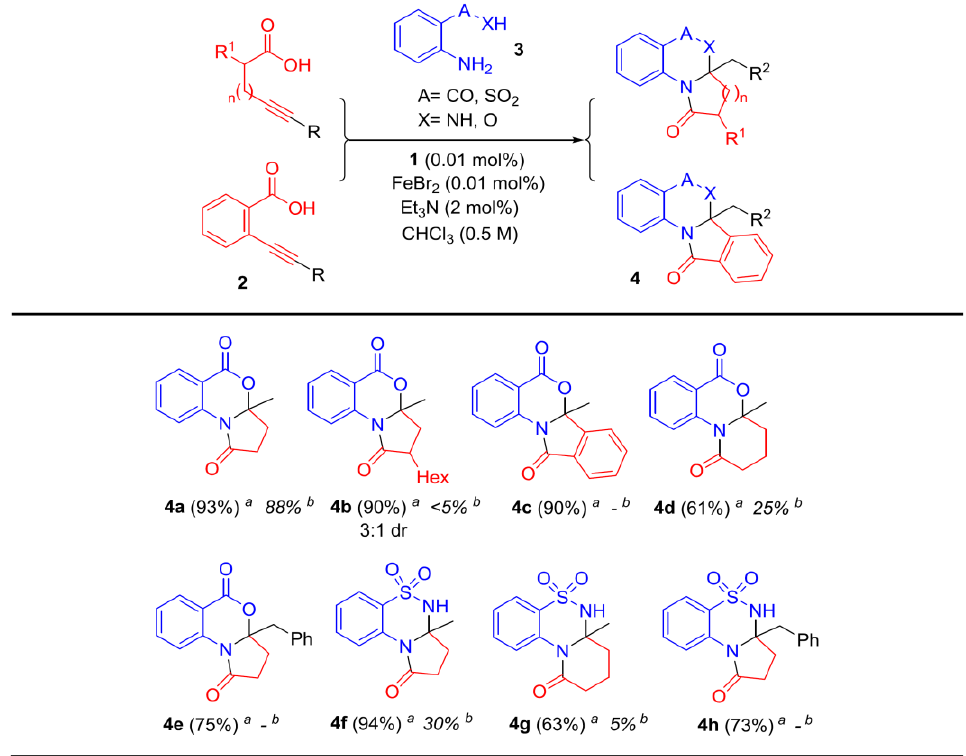
Figure 3. Palladium-catalyzed cascade reaction between alkynoic acids and o -aminobenzoic acid or o -aminobenzenesulfonamide.